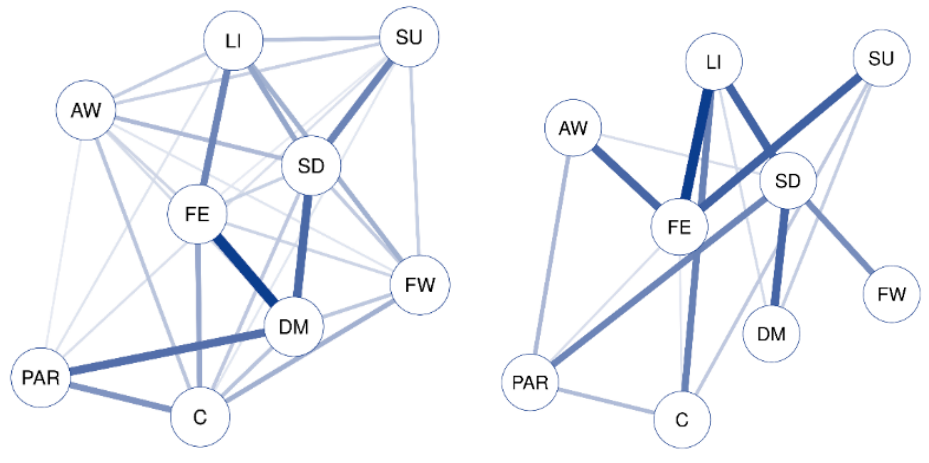
Figure 2. CIDI65+ symptoms network for females and males. Each node represents an item, and each link represents a relation between each pair of items (bolder lines indicate stronger relations). DM: